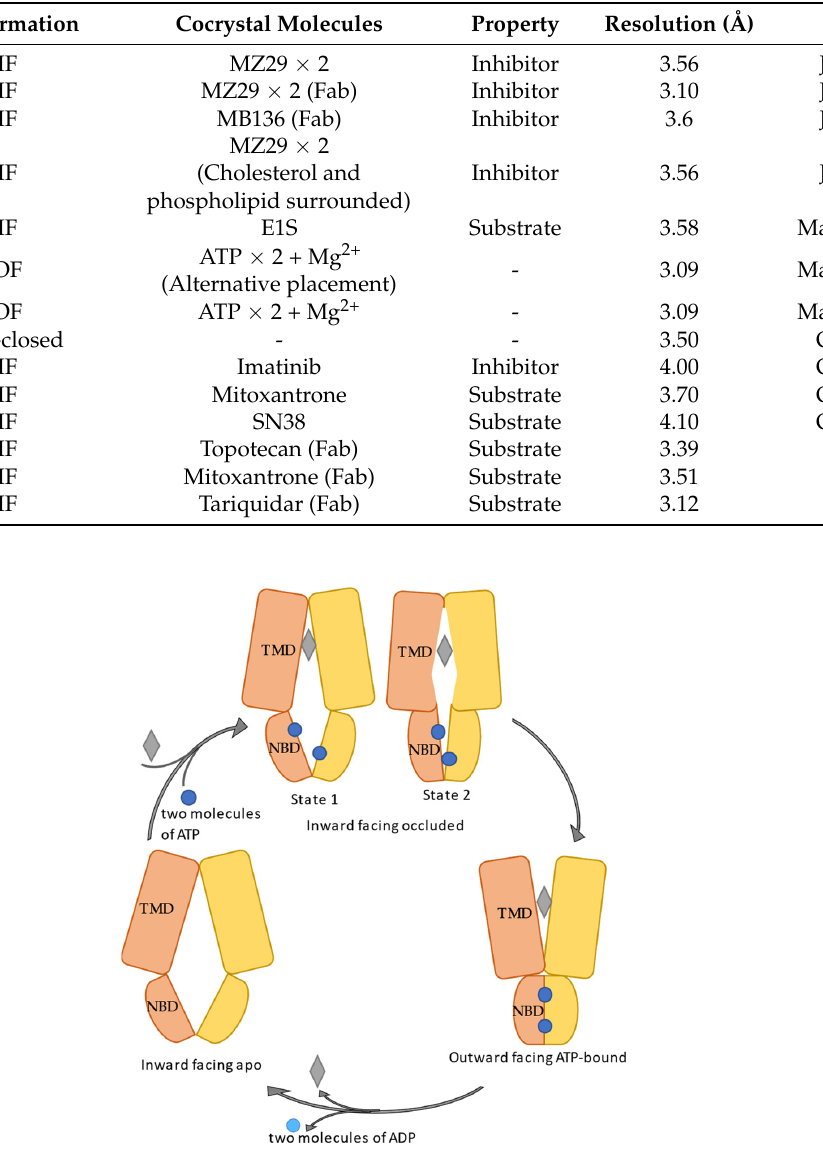
Figure 3. Schematic illustration of the conformational change during the transport cycle of ABCG2. Orange and yellow cartoons represent two monomers, each with one TMD and one NBD. Dark blue spheres are ATP molecules, light blue spheres represent ADP, while the substrate is shown as grey rhombus.